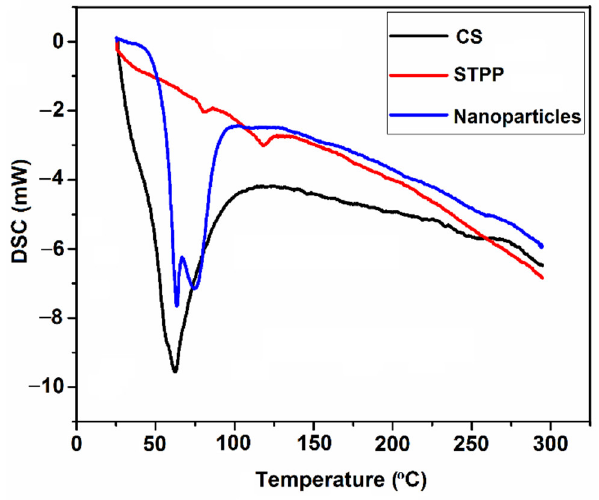
Figure 5. DSC thermograms of chitosan (CS), sodium tripolyphosphate (STPP), and CS nanoparticles (CSNPs).